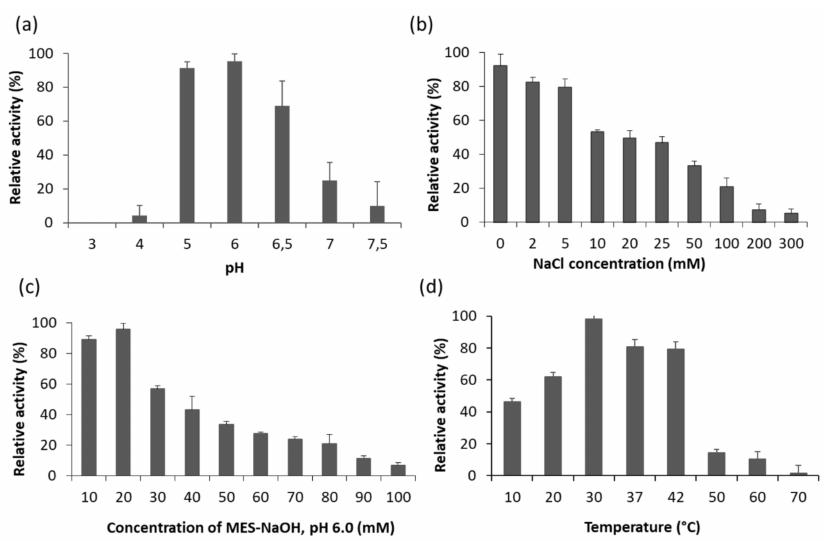
Figure 6. Effects of ( a ) pH; ( b ) NaCl; ( c ) the optimal value of the buffer concentration; and ( d ) temperature on the lytic activity of LysB against C. sporogenes ATCC 7955 cells. Relative ac- tivity was calculated by comparing the lytic activity at a specific condition with the maximal lytic activity within the dataset. Each experiment was repeated in triplicate, error bars indicate the standard